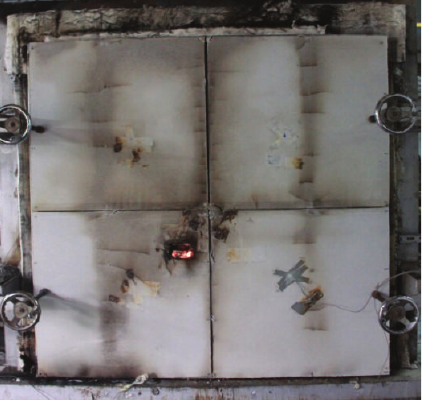
Figure 14: The result of the unexposed surface of the specimen after 40 min standard fire test in Test 3.